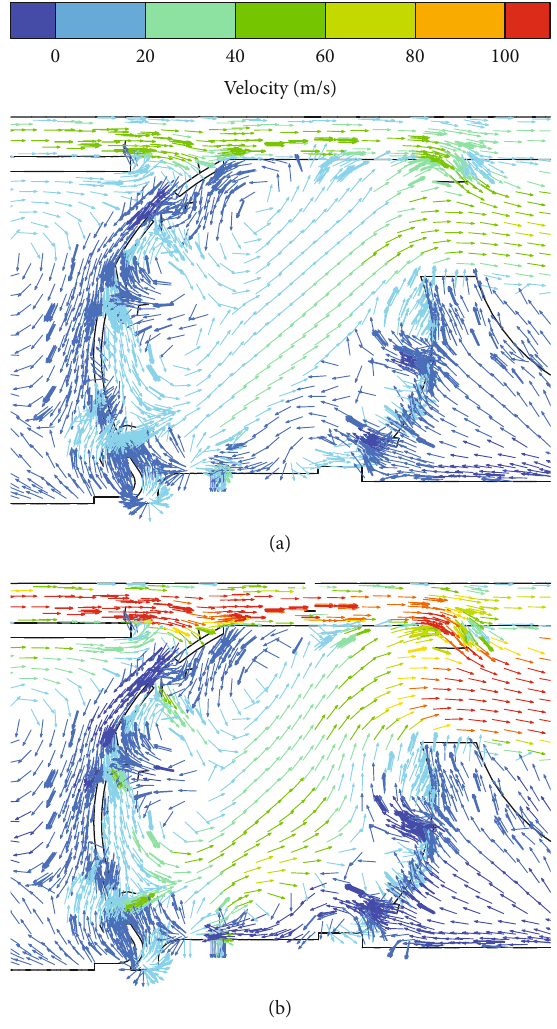
Figure 5: Nonreacting fl ow computational results at two working conditions: (a) idle design of speed and (b) 80% design of